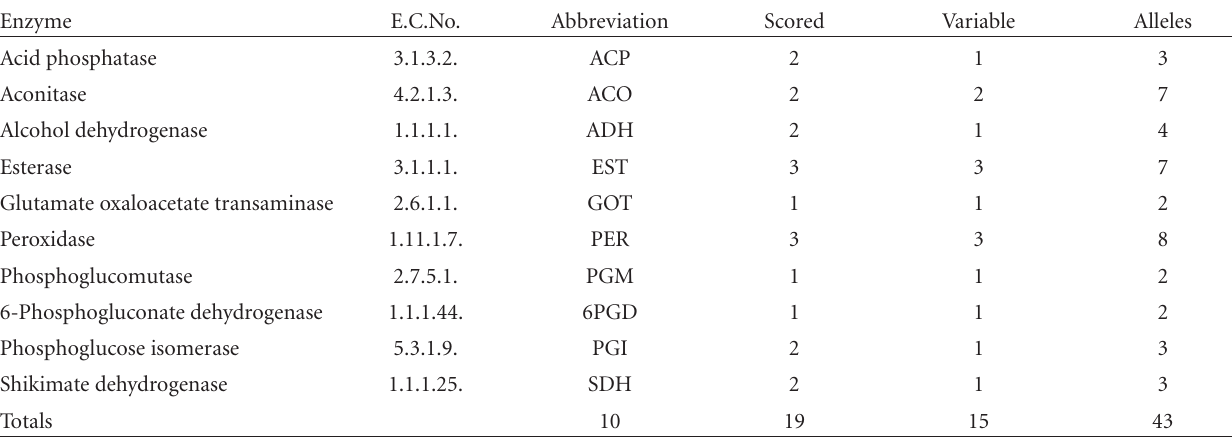
Table 3: Enzymes investigated, their enzyme commission number (E.C. No.), abbreviation, and numbers of scored loci, variable loci, and alleles.